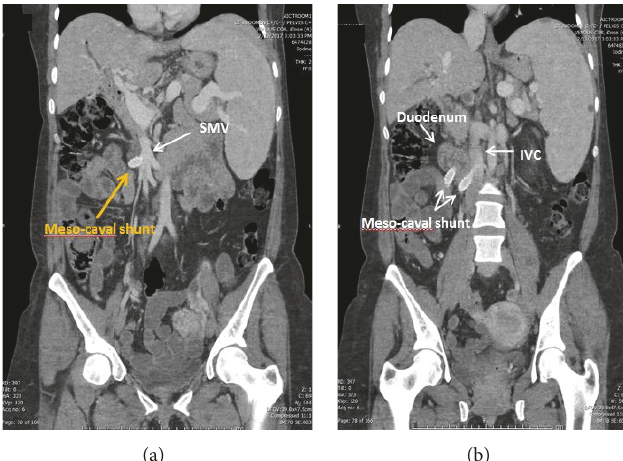
Figure 4: Coronal view on computed tomography showing the mesocaval shunt (yellow arrow) originating from the SMV and inserting into the infrarenal